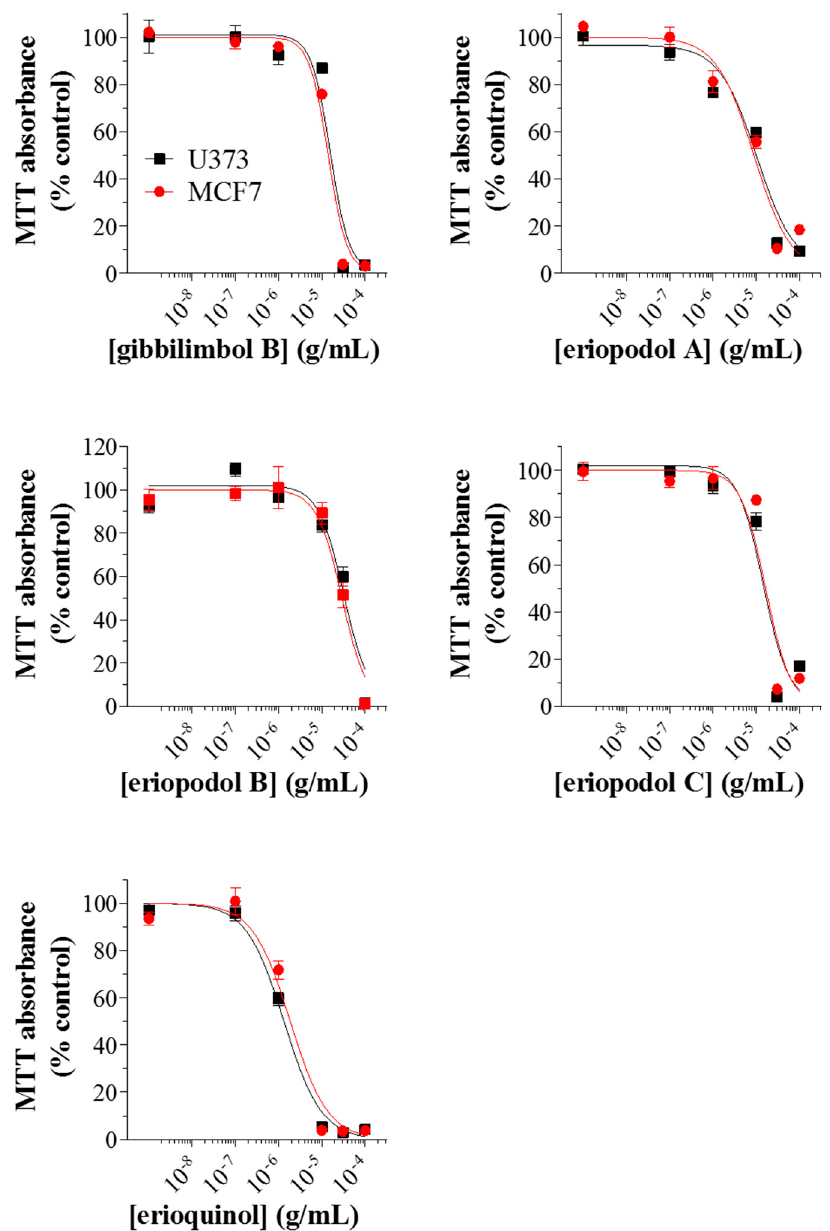
Figure 2. Piper genus-derived compounds exhibit cytotoxic effects in human cancer cells. U373 and MCF7 cells were treated with increasing concentrations of gibbilimbol B, eriopodol A, eriopodol B, eriopodol C, and erioquinol for 24 h before 3-(4,5-dimethylthiazol-2-yl)-2,5-diphenyltetrazolium bromide (MTT) assay. Results are expressed by setting the absorbance of the reduced MTT in the respective control (vehicle-treated) samples, i.e., absence of compounds, as 100%. The data points are